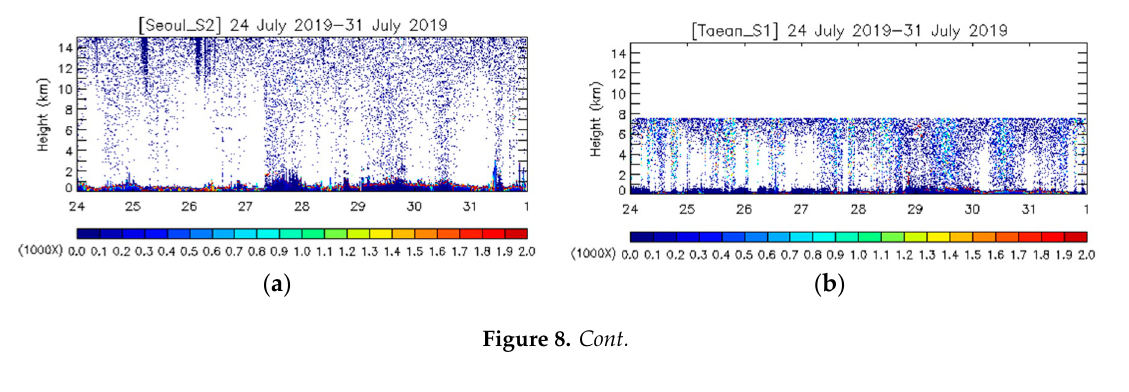
Figure 7. Examples of a winter case on 24–31 January 2019 at ( a , c ) Seoul (Seoul_S2 station), ( b,d ) Taean (Taean_S1 station); ( a , b ) backscatter profiles and ( c , d ) CBHs detected by ceilometer over Seoul. The colorbar represents the intensity of backscatter signals. The cyan, purple, and red triangles indicate the 1st, 2nd, and 3rd CBHs, respectively.